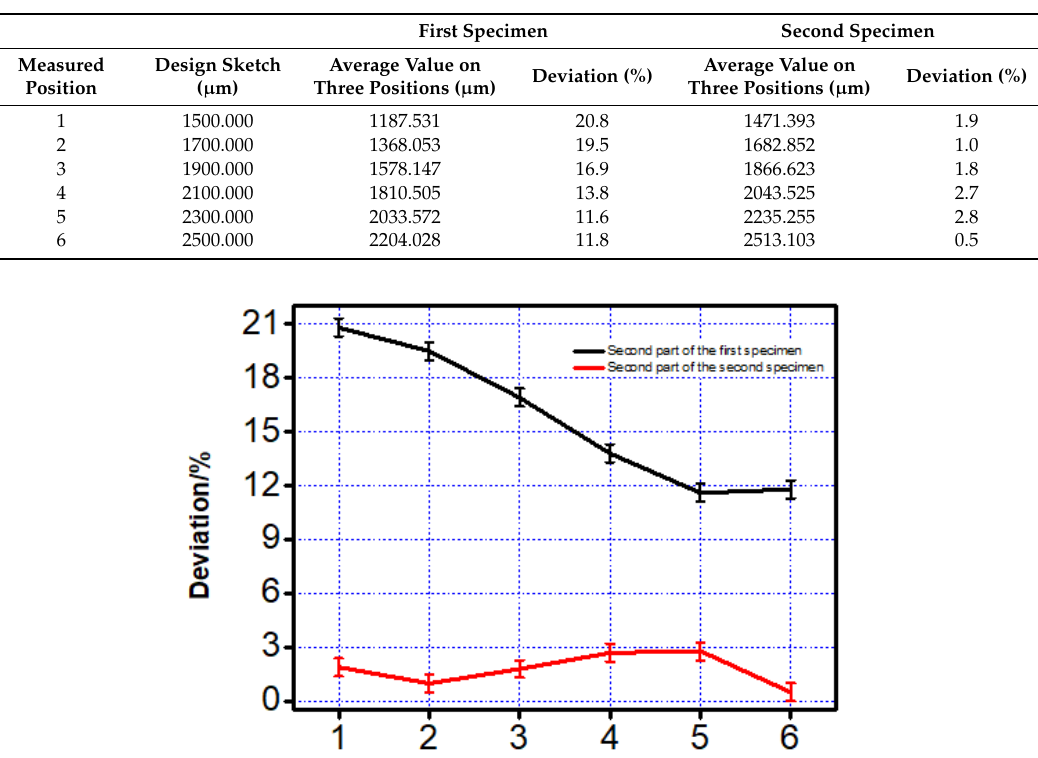
Table 4. Measured data on the second part of the two specimens printed by the first two scanning strategies.